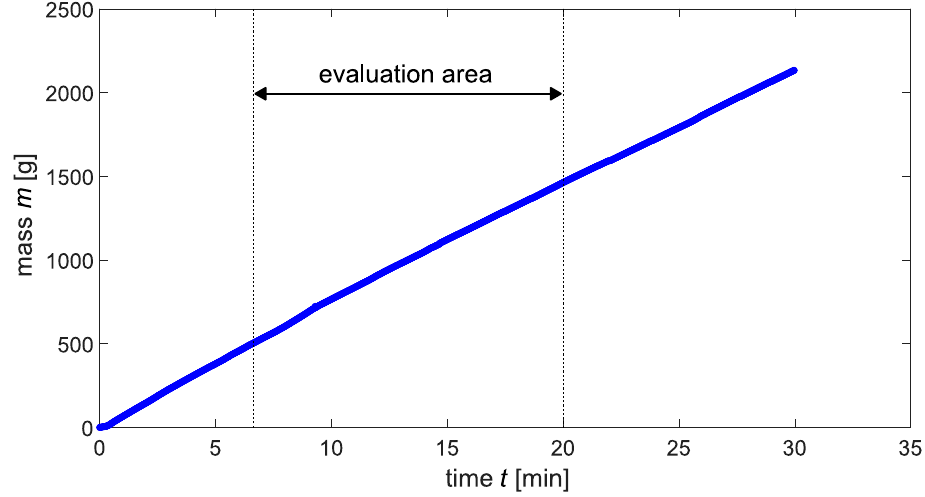
Figure 14. Exemplary result of a permeation experiment.